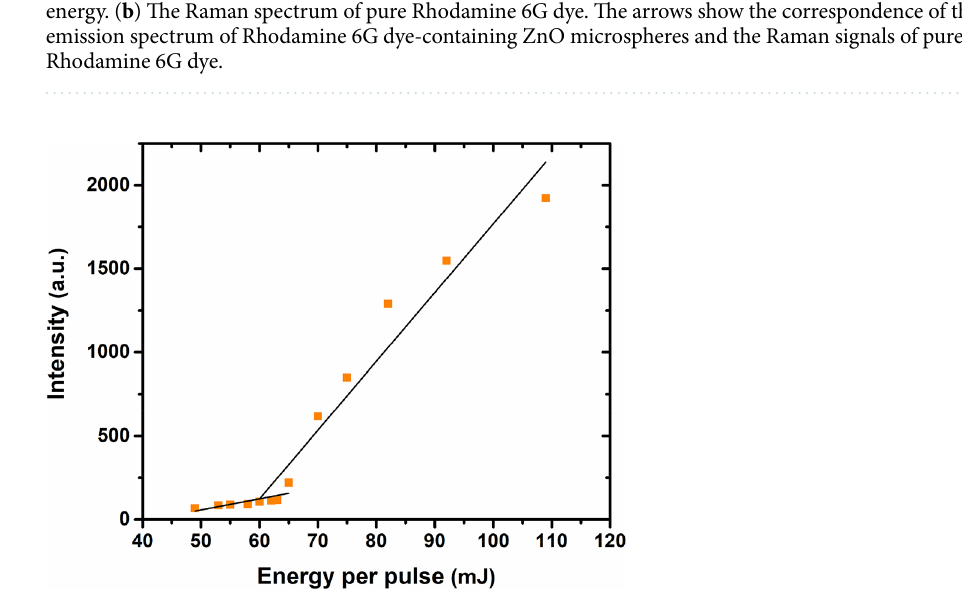
Figure 6. Output intensity versus incident pump energy at the first Raman signal (578 nm) from Rhodamine 6G solution containing ZnO